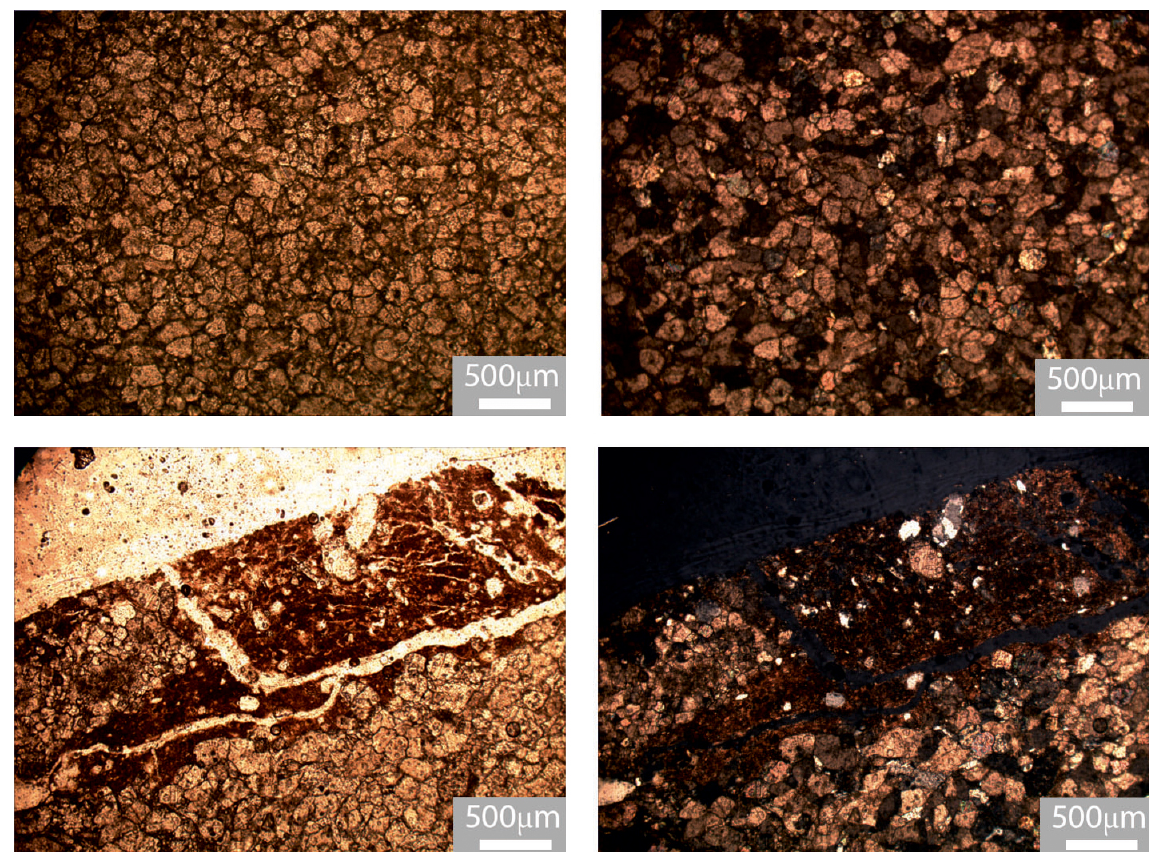
Figure 12. Detail of vugs cemented by equigranular sparitic calcite related to microcodium structures.